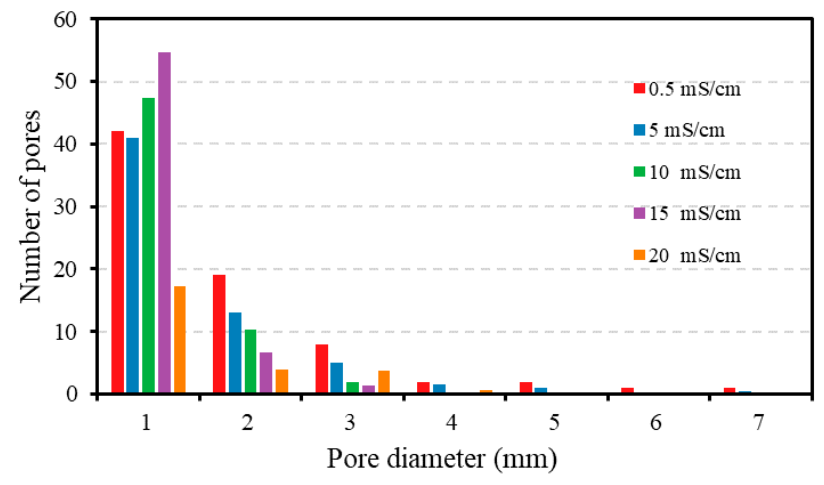
Figure 15. Number of pores on the sample surface under different electrical conductivity.